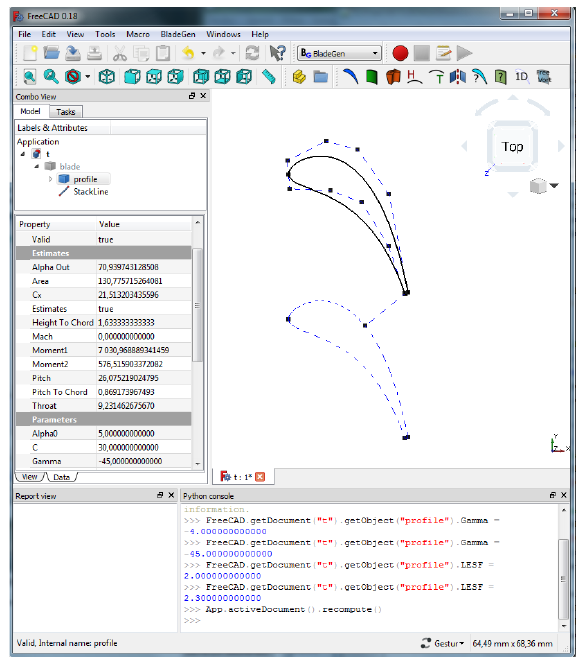
Fig. 2. Design of a profile shape in the GUI.